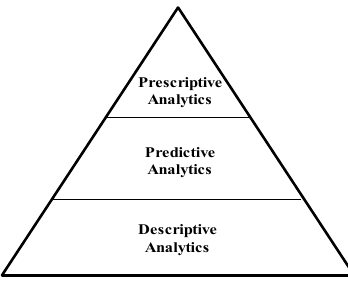
Figure 1. Hierarchy of descriptive, predictive and prescriptive analytics.